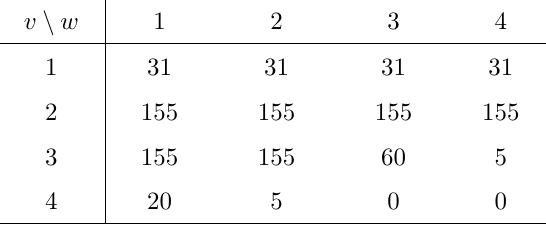
Table 10: ( v, w )-linearity of KECCAK 5-bit S-box